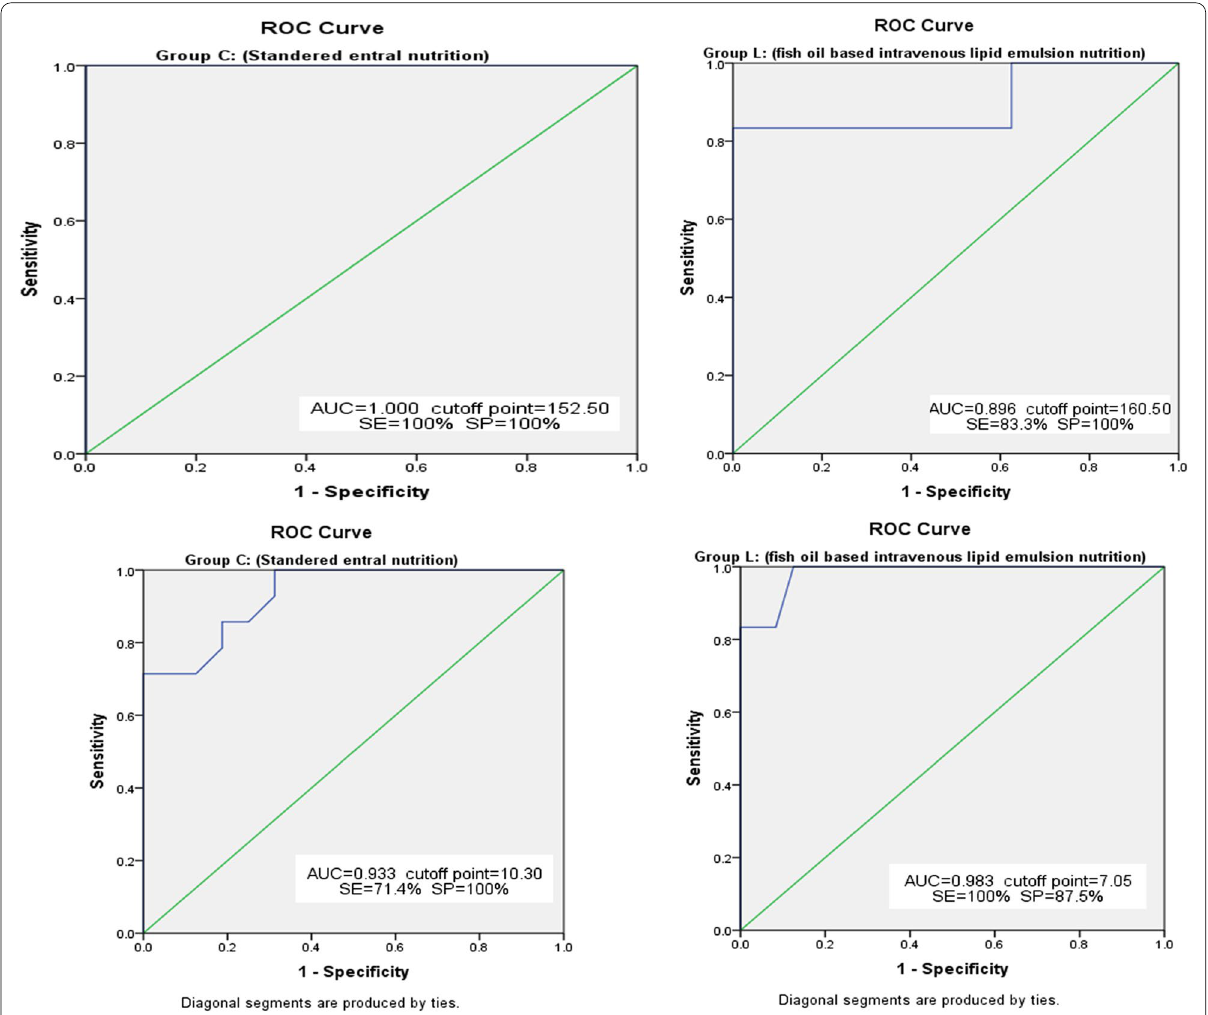
Fig. 1 The 7th-day P/F & NLR ROC curves and their correlation in predicting failed conventional care and shift to ICU between the studied